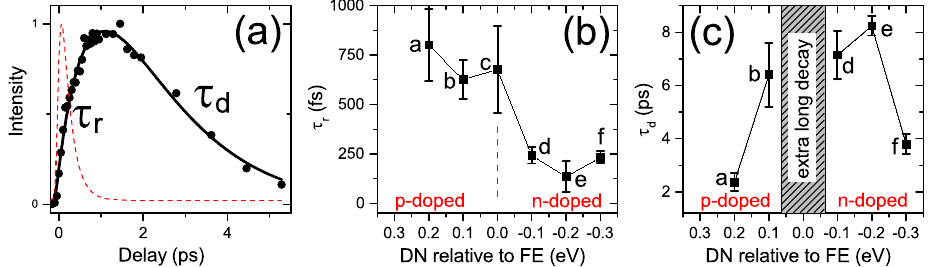
Figure 5. ( a ) Typical phenomenological fit of TSS electronic dynamics (data of Sb 2 Te 3 sample): exponential growth with rise-time τ r , followed by an exponential decay with time constant τ d . The function is convoluted with the TARPES response time of ≈ 80 fs. TSS rise times ( b ) and decay times ( c ) of the different BSTS samples as a function of the DN energy relative to the Fermi level. The extra-long decay dynamics of Bi 0.8 Sb 1.2 Te 3 (DN = 0 eV) cannot be fit within our experimental time window and the corresponding region is marked by the dashed